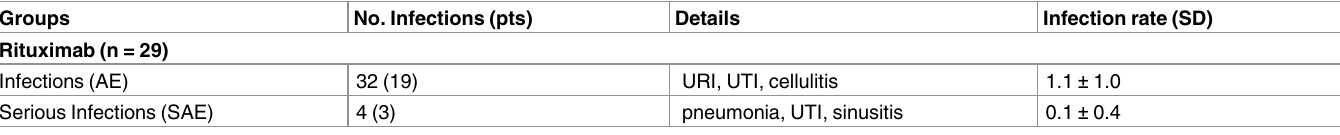
Table 2. Comparison of adverseevents between the rituximab treated group and the control group.